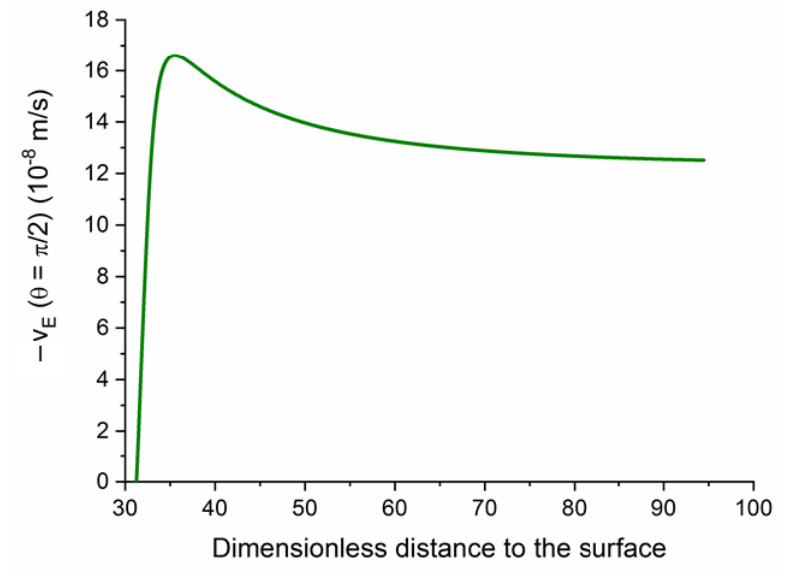
Figure 3. Profile of the component of the fluid velocity, relative to the particle, parallel to the external field, v E (for θ = π /2 ) for latex particles (1000 nm diameter and − 10 µ C/cm 2 surface charge density), coated by a single polyelectrolyte layer 40 nm thick, and charged with + 7 × 10 5 C/m 3 . The distance is measured relative to the electrical double layer thickness of the core particle.